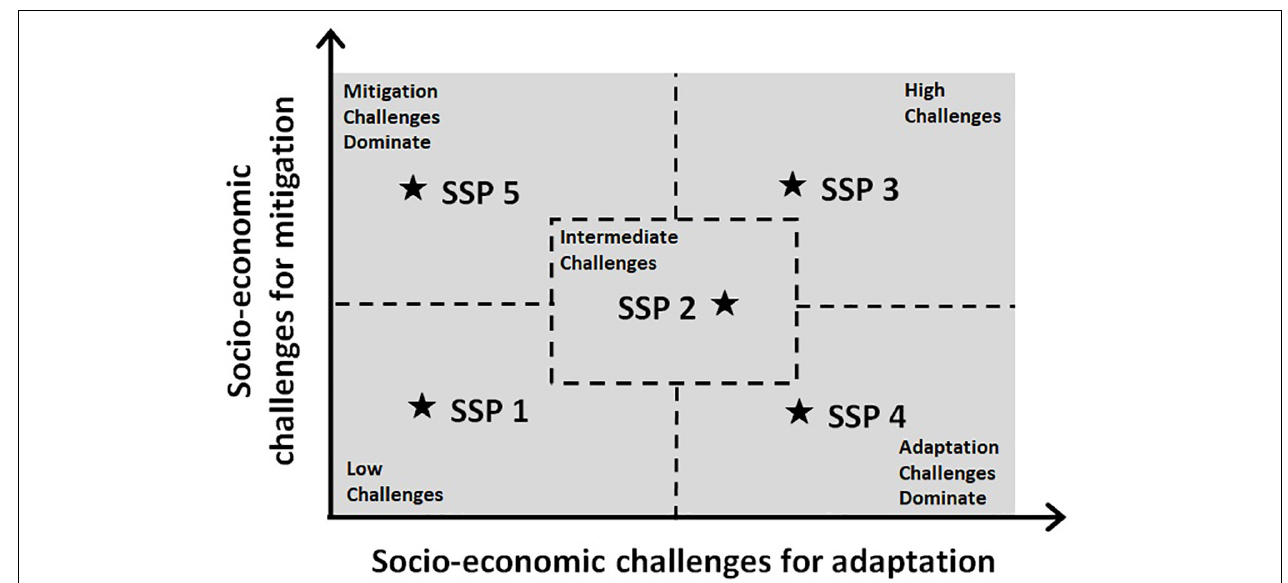
FIGURE 2 | Five shared socioeconomic pathways (SSPs) representing different combinations of challenges to mitigation and to adaptation (based on O’Neill et al., 2014).